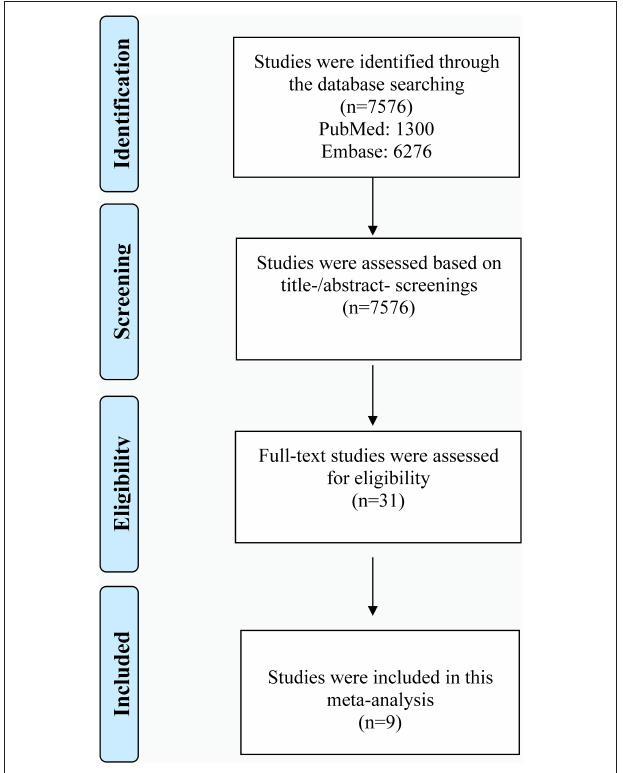
FIGURE 1 | Diagram of study selection process of our